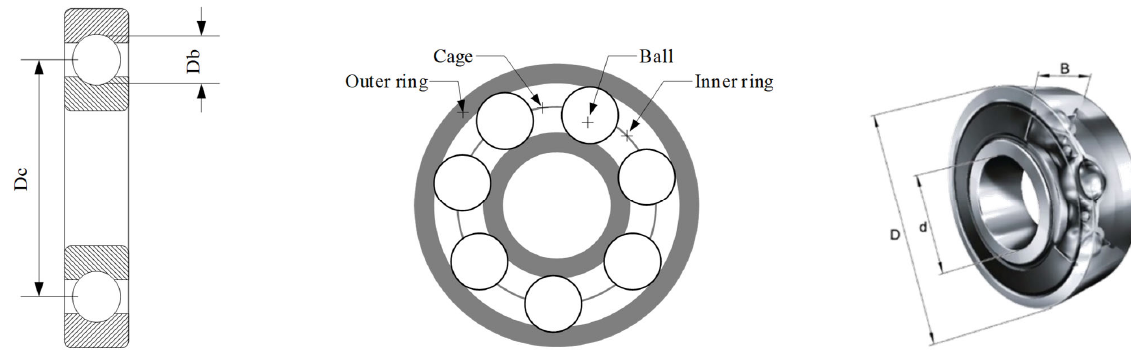
Figure 2. Bearing Figure 2. Bearing composition .